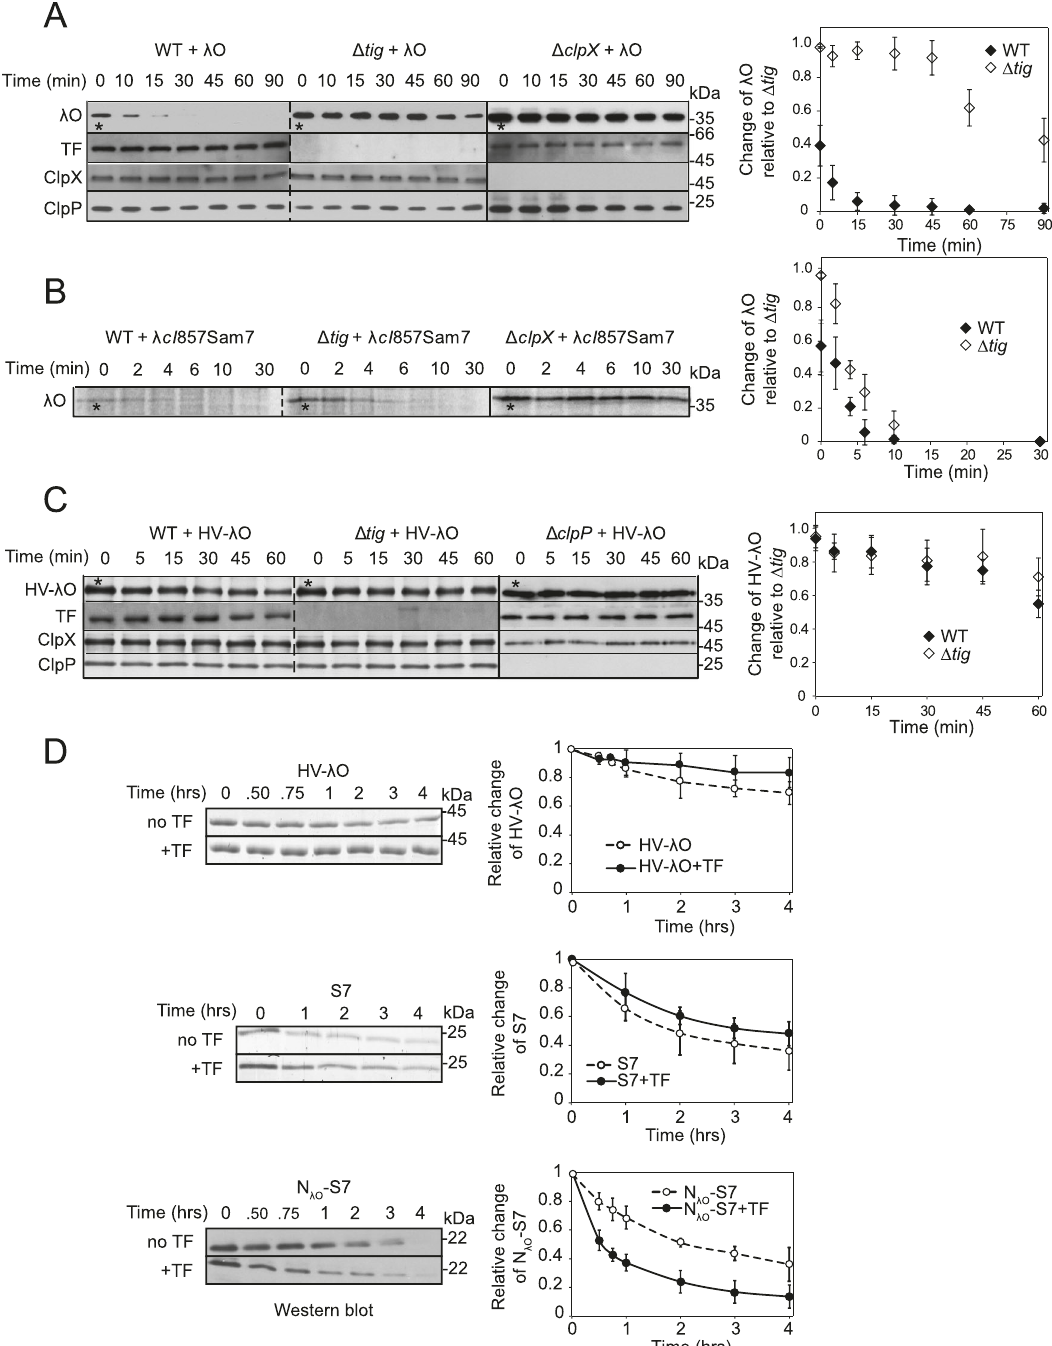
Fig. 2 The role of TF in the cellular degradation of λ O. A Western blot analysis of the degradation of overexpressed λ O as a function of time after inhibition of protein synthesis in MC4100 WT, Δ tig , and Δ clpX cells. About 10 5 cells were loaded for each time point. Reactions separated by dashed lines are from the same gel, while those separated by solid lines are from different gels. Curves on the right show the quanti fi cation of the bands. The error bars calculated here and in ( B – D ), are the standard deviation based on three independent experimental repeats. The stars highlight the zero time point directly after inhibition of protein synthesis. B MC4100 WT and Δ tig lysogens carrying heat-inducible prophage λ cI 857Sam7 were heated at 42 °C for 8 min to induce phage protein expression. A pulse-chase experiment followed by immunoprecipitation of λ O protein was performed to monitor endogenous λ O degradation over time. Quanti fi cation of the λ O band as a function of time is shown on the right. C Same as in A but using N-terminal HV- tagged λ O. D In vitro degradation assay of HV- λ O, S7, and N λ O -S7 by ClpXP in the absence or presence of TF. Quanti fi cations of the substrate bands are shown on the right. Western blots were performed for N λ O -S7 (22 kDa) using an α -S7 antibody (dilution 1:2000) due to the close proximity in its migration to ClpP (23 kDa) on SDS-PAGE gels. Source data are provided as a Source Data fi le.